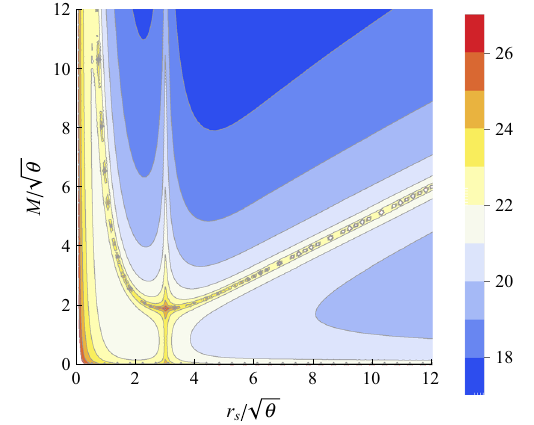
Fig. 2 Mass accretion rate for accreting fluid of (cid:12) = 1 . 5 is plotted along the color axes as a function of r s /